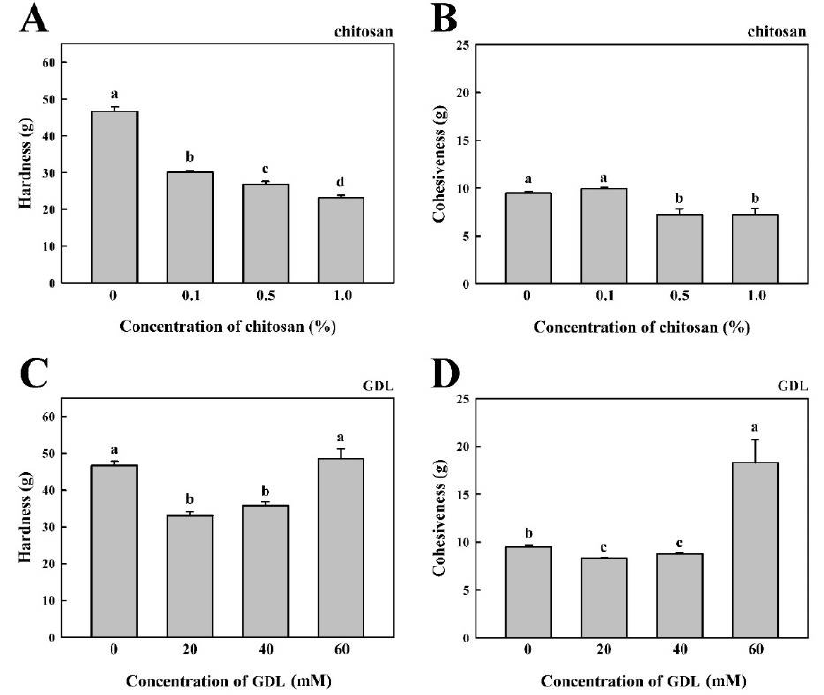
4 of 9 Figure 1. Appearance of pea-based tofu with and without chitosan or GDL: ( A ) without chitosan or GDL, ( B ) with 0.5% chitosan, and ( C ) with 20 mM